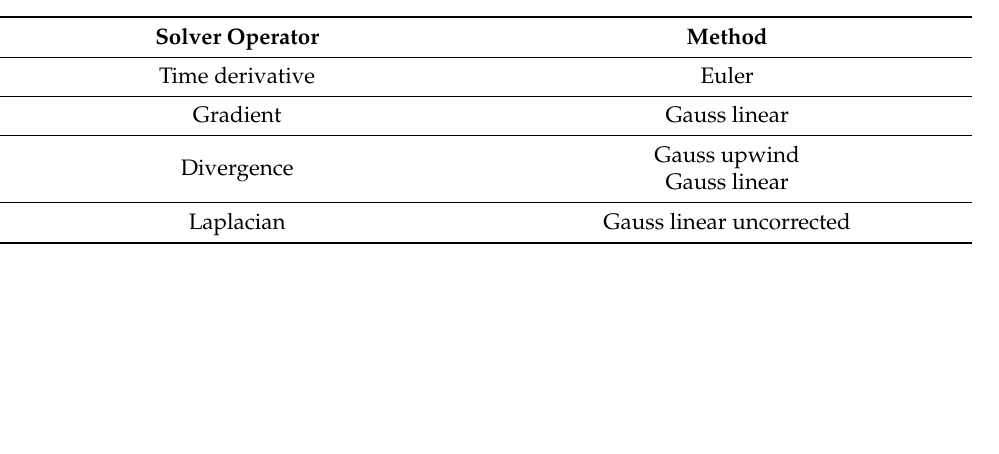
Table 2. Numerical methods applied in BoussinesqRTDFoam solver.